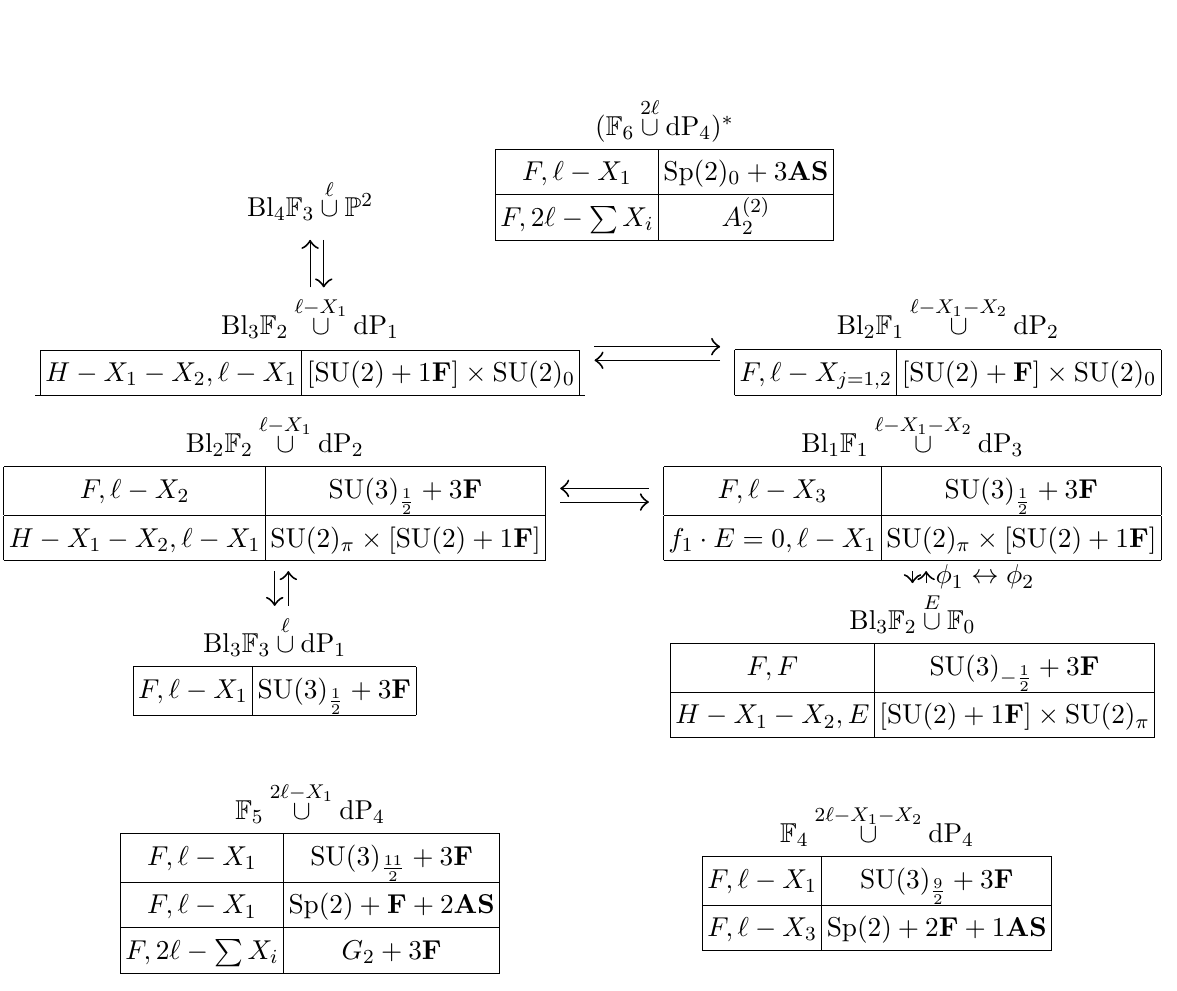
Figure 22. M = 4 geometries,